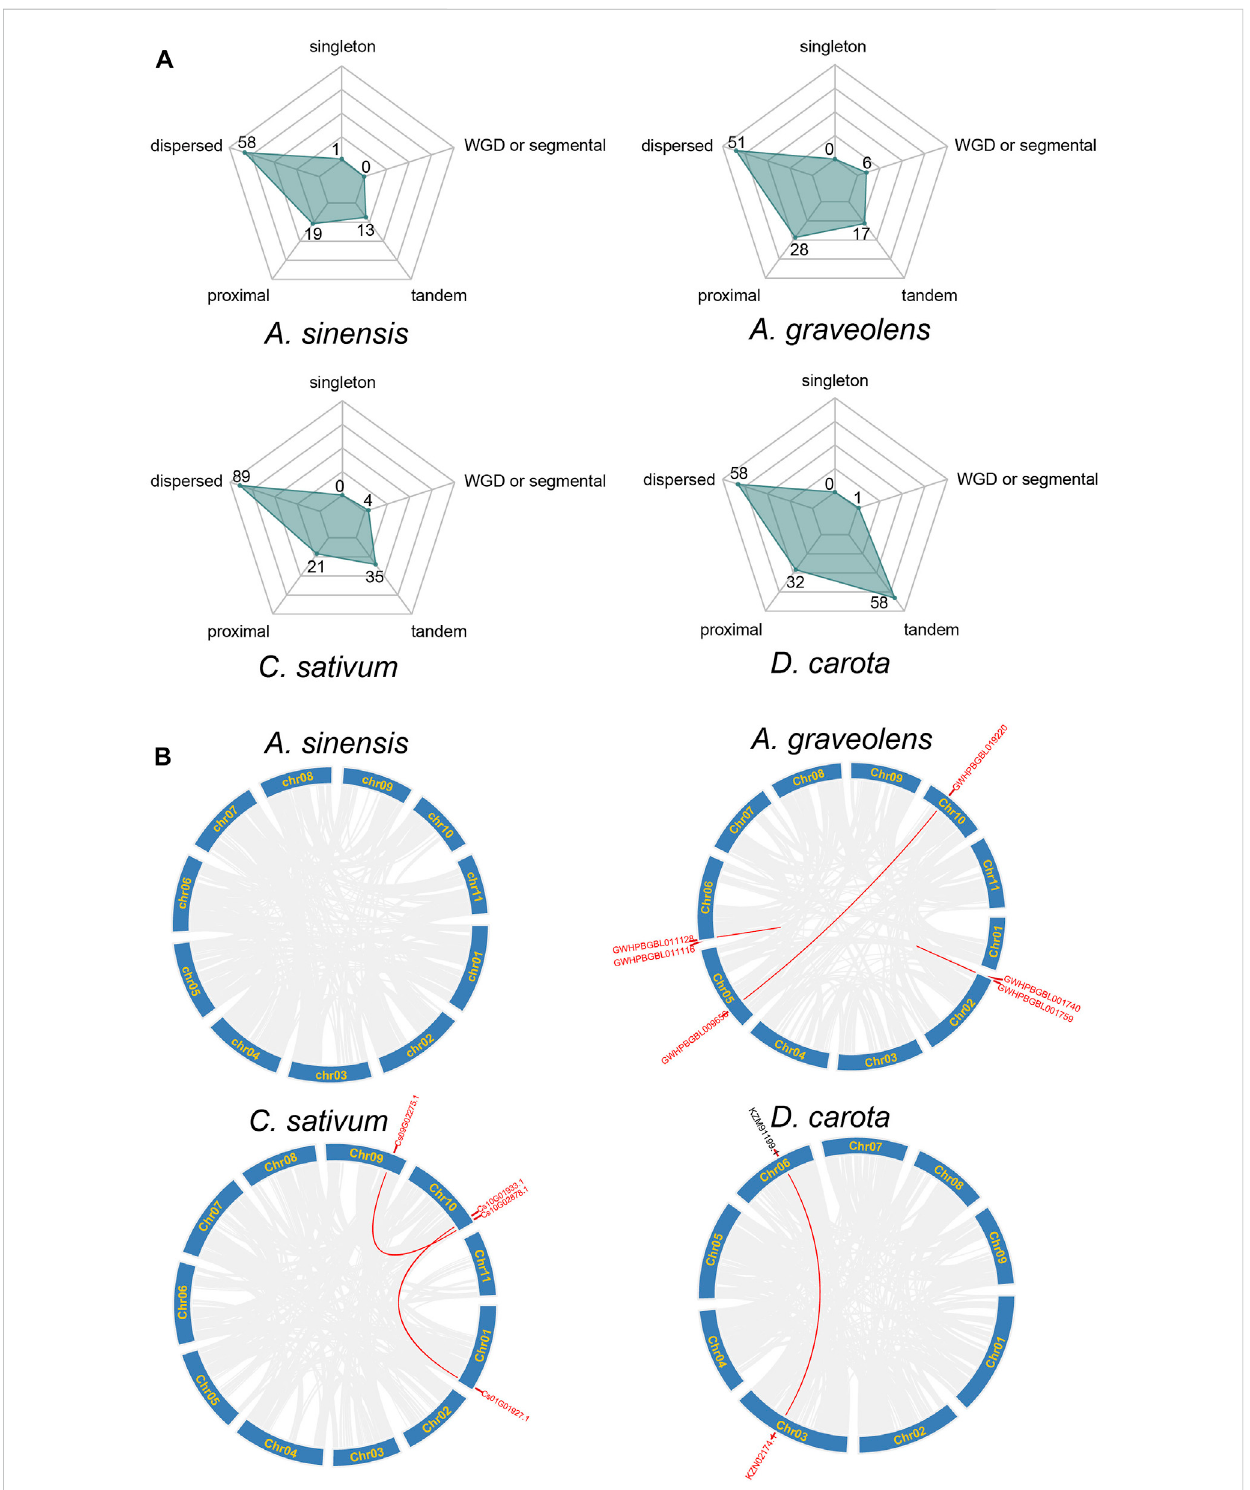
FIGURE 3 Duplication types of NLR genes across Apiaceae species. (A) Type of NLR gene duplication in A. sinensis , A. graveolens , C. sativum and Daucus carota ,respectively.ThenumberofNLRgenesderivedfromeachtypewasshown. (B) SyntenicrelationshipsofNLRgenesin A.sinensis , A.graveolens , C. sativum and Daucus carota , respectively. Gene ID in red represents NLR genes and gene ID in dark belongs to non-NLR